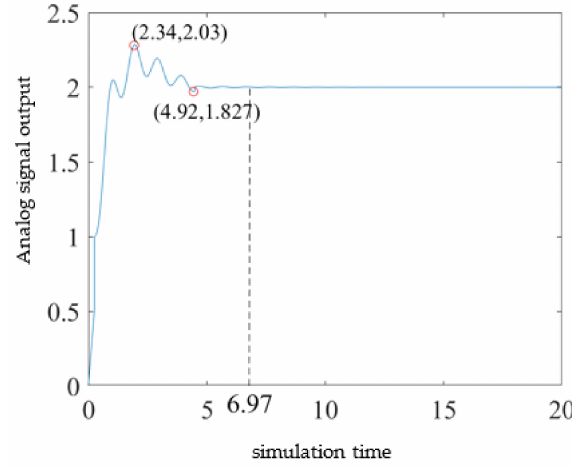
Figure 13. Simulation waveform of BPNN–PID control